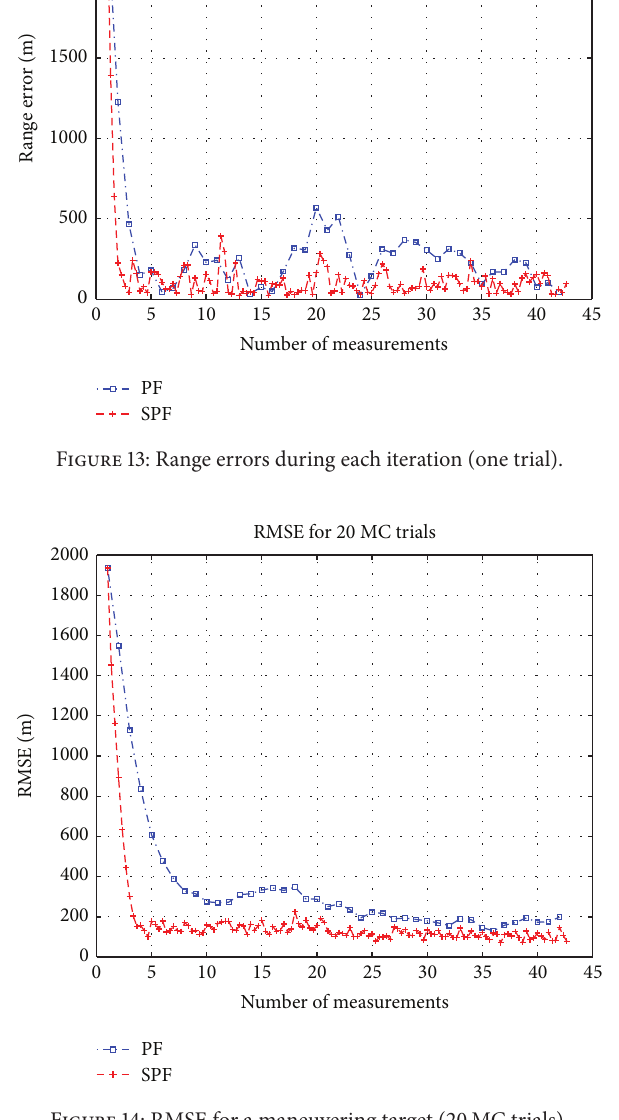
Figure 14: RMSE for a maneuvering target (20MC trials).